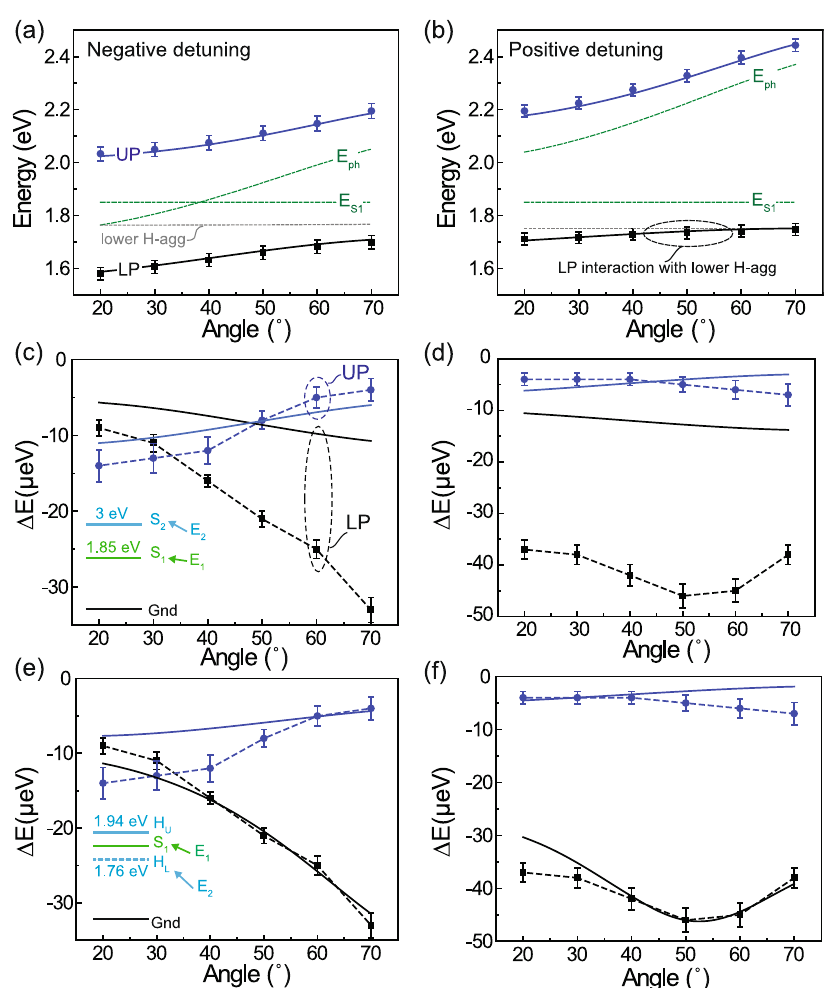
Fig. 5 | Coupled oscillator model of polariton electroabsorption. Polariton dis- persion relations for the a negatively- and b positively-detuned 40wt% SQ:NPB microcavities. The solid markers are determined from fi tting the experimental re fl ectivity minima in each case (error bars re fl ectthe standard error in fi ttedpeak position)andthesolidlinesarecalculatedusingthecoupledoscillatorHamiltonian given in Eq. (1) from the text. The green dashed lines denote the bare cavity mode and SQ exciton energies, while the gray dashed lines re fl ect the energy of the proposed lower H-aggregate state. Note that there is ostensibly a third, H- aggregate-like branchinthe polariton dispersionof each cavity (not shown) thatis predicted by Eq. (1) and closely coincides with the lower H-aggregate state (i.e. the graydashedline);thisbranchisnotobservedexperimentallybecauseitsamplitude is very small (owing to weak coupling of the H-aggregate state to the cavity) and thus is dominated by the much stronger LP feature. c Field-induced LP and UP energy shifts derived for the negatively-detuned cavity based on the re fl ectivity